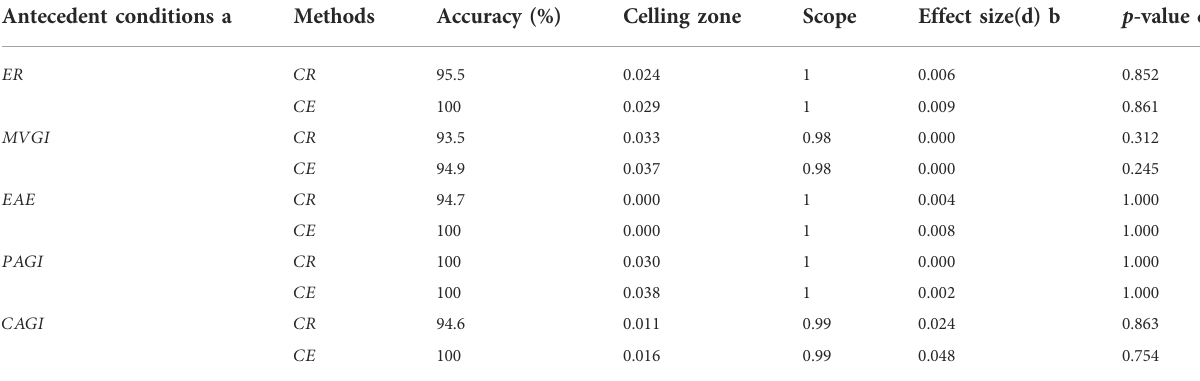
TABLE 1 Results of the analysis of the necessary conditions for the NCA method. Antecedent conditions a